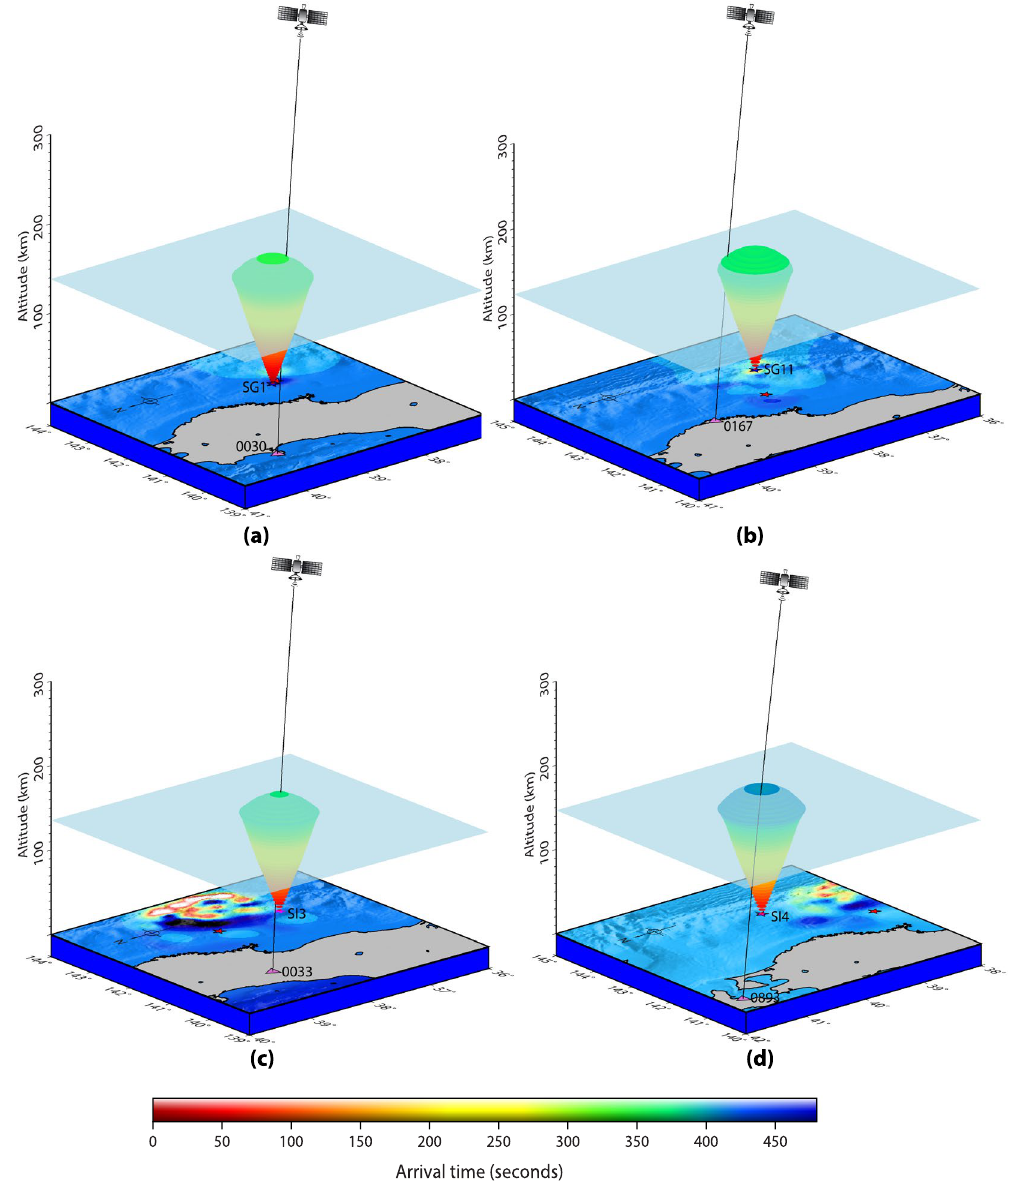
Figure 5. 3D model identifying the seismic sources of CIP observed by PRN 05 from ( a ) 0030, ( b ) 0033, ( c ) 0167, and ( d ) 0893 GPS stations. From our model analysis, these CIP are induced by SG1, SI3, SG11, and SI4 respectively. The first interactions between the PRN 05 LOS from these stations and the rays from SG1, SI3, SG11 and SI4 respectively at ~441 s, ~473 s, ~469 s and ~509 s at the respective altitude of ~138 km, ~135 km, ~121 km and ~141 km are shown. Other information is the same as Fig. 3. The figure is prepared using the GMT 5.4.1 43